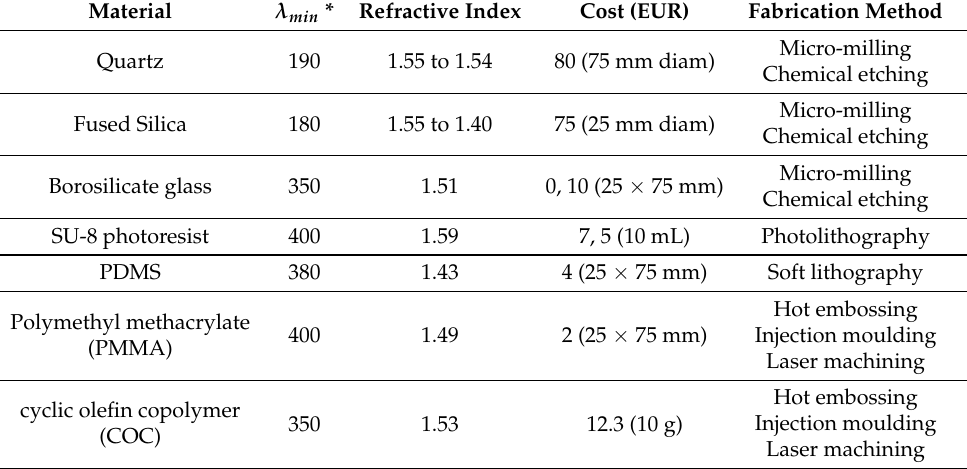
Table 1. Material and physical characteristics of common materials used in OMLoC fabrication (gathered from varying suppliers such as Edmond Optics [120], Neyco Materials [121], Sigma Aldrich [122]) ( λ min * represents the minimum wavelength (nm) transmitted by the material).